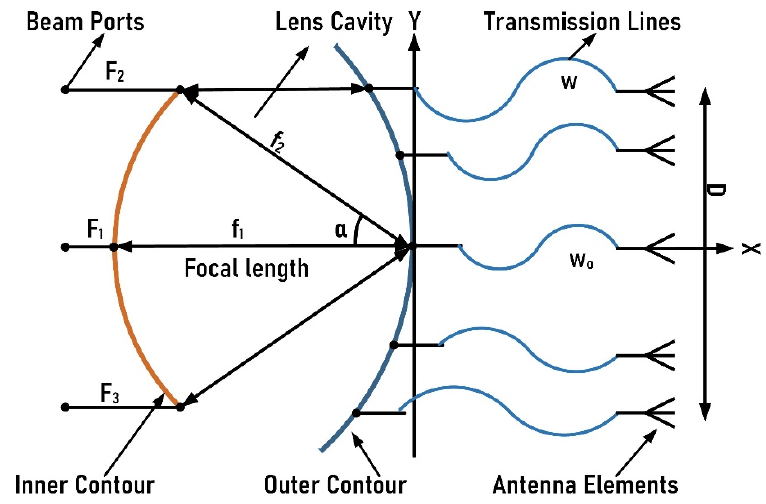
Figure 1. Basic schematic of a Rotman lens.